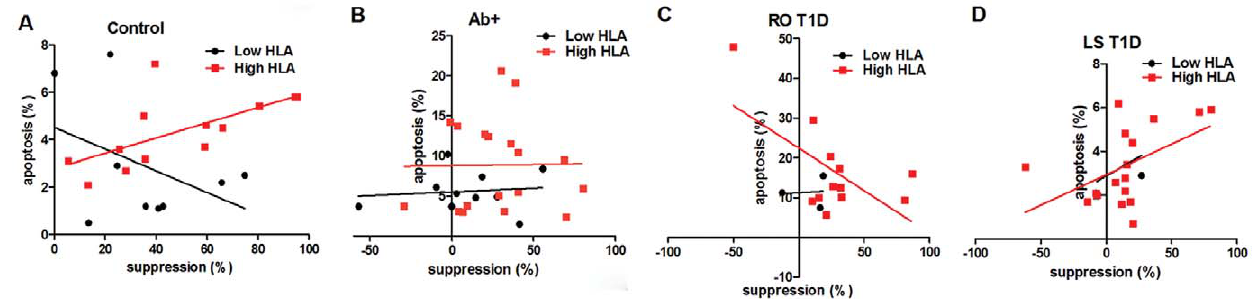
Figure 2. Changes in correlation of HLA risk with Treg apoptosis and Treg function in subject cohorts representing stages of T1D development. In High HLA risk both healthy control and LS T1D subjects, increased Treg apoptosis significantly correlated with increased Treg function (p=0.017 and p=0.042, respectively). High HLA risk RO T1D subjects showed opposite correlation: increased Treg apoptosis was correlated with decreased Treg function (p=0.027). Multiple Ab + subjects did not show correlation between Treg apoptosis and function in High HLA risk group (p=0.95). Although some trends were present, Low HLA risk groups did not show correlation with Treg apoptosis and function.